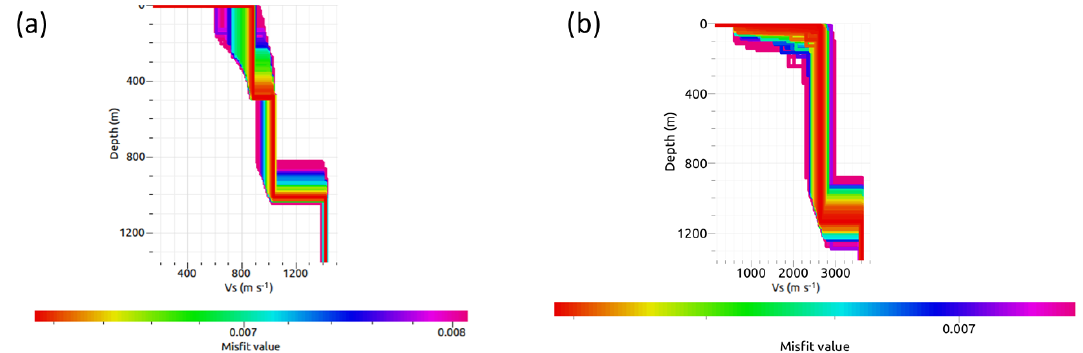
Figure 14. Results of inversion of averaged dispersion curves for station pairs of Group 1 (a) and Group 2 (b) . The plots demonstrate the ensemble of all velocity models that equally fit the data and prior information. The colour scale indicates the value of the misfit function.